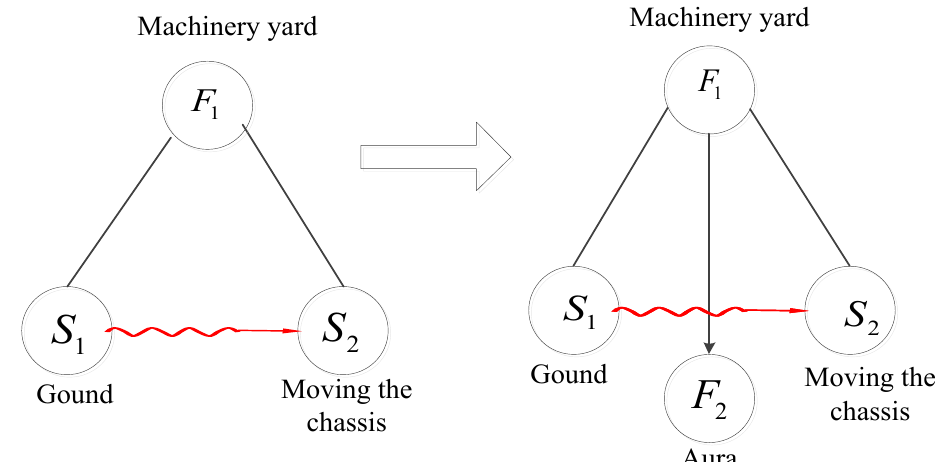
Figure 3. Substance–field model with gas field.